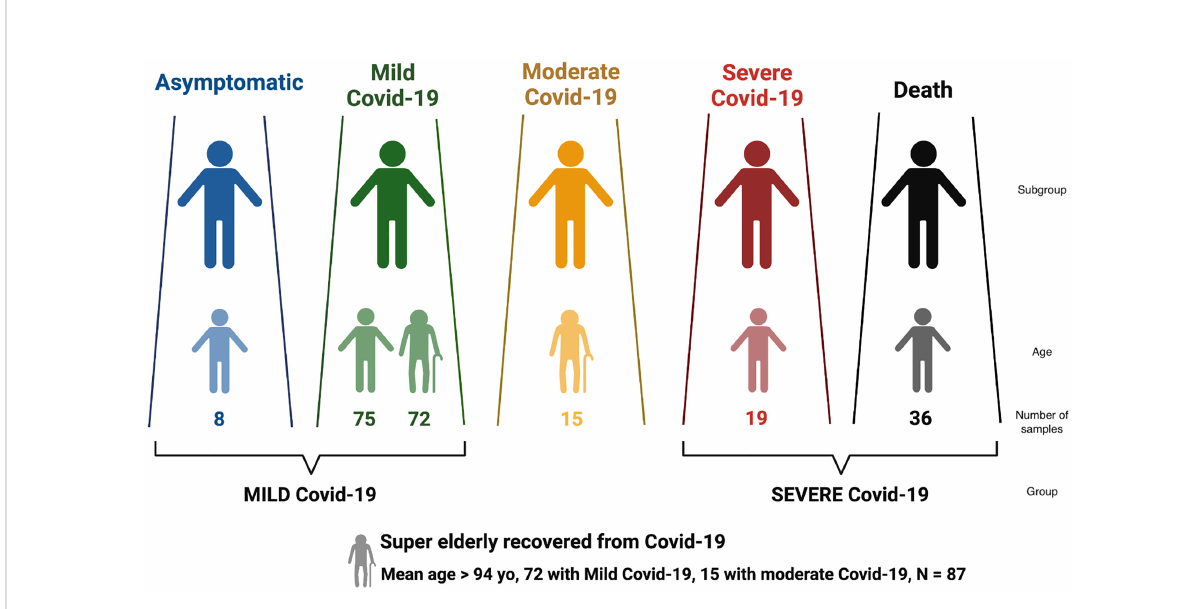
FIGURE 1 Distribution of Brazilian individuals with SARS-CoV-2 infection according to Covid-19 severity, and the de fi nition of the larger groups MILD and SEVERE